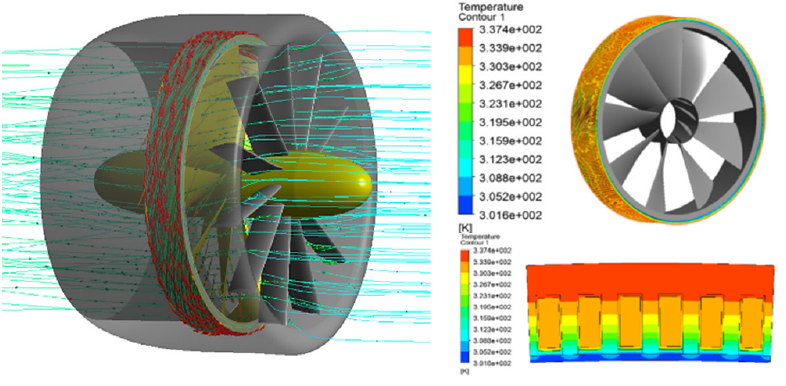
Figure 10. Multifield simulation of IMP [85].